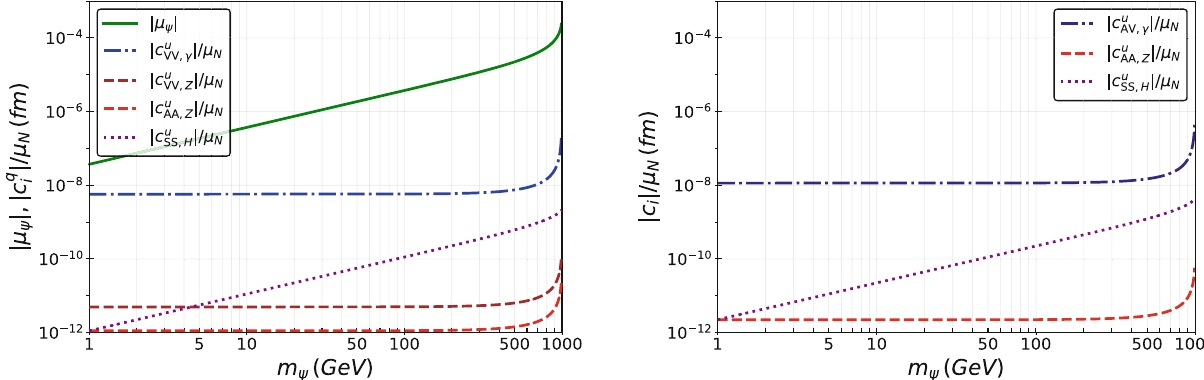
Fig. 2 Wilson coefficients at the quark level (with up-type quarks) versus the DM mass m ψ . The Higgs portal coupling is λ HS = 3. The vector and scalar coefficients which originate from the photon, Z and Higgs penguin diagrams, respectively, have been rescaled by the